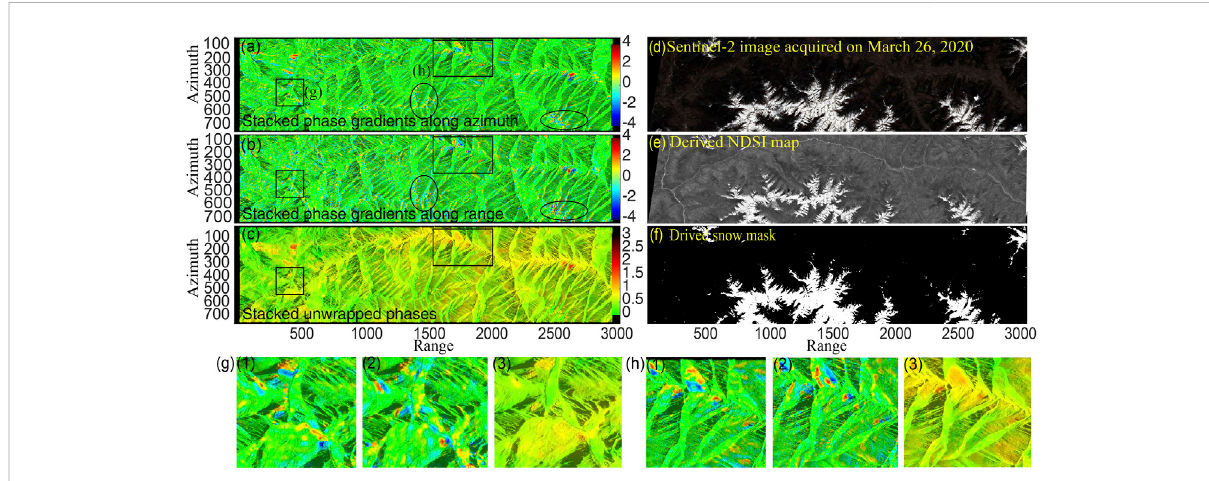
FIGURE 4 Comparison between phase-gradient stacking and unwrapped-phase stacking in the azimuth (A) and range direction (B) . (C) Shows stacked unwrapped phases. (D) Sentinel-2 image for masking acquired on 26 March 2020 and (E) derived NDSI map and (F) snow mask. (G,H) are